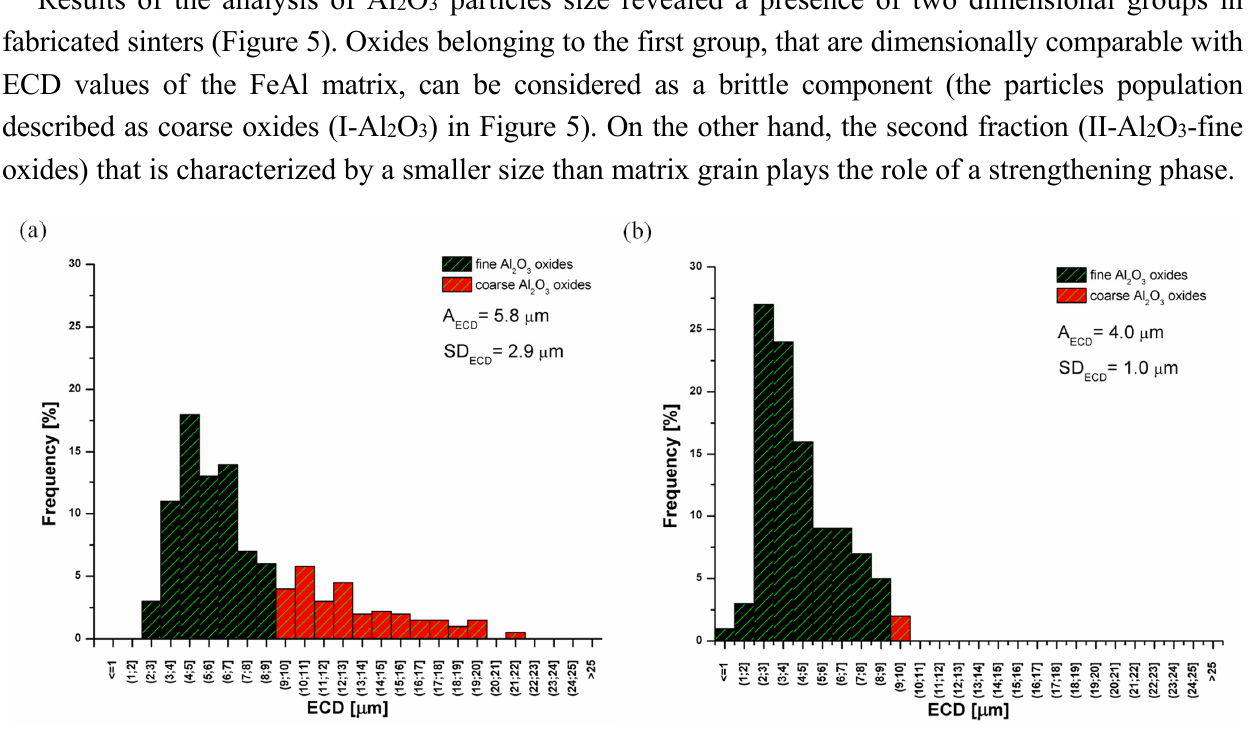
Figure 5. Distribution of Al 2 O 3 oxides equivalent diameter: ( a ) The pre-sintering at 620 °C, 0 Hz, ( b ) The pre-sintering at 670 °C, 60